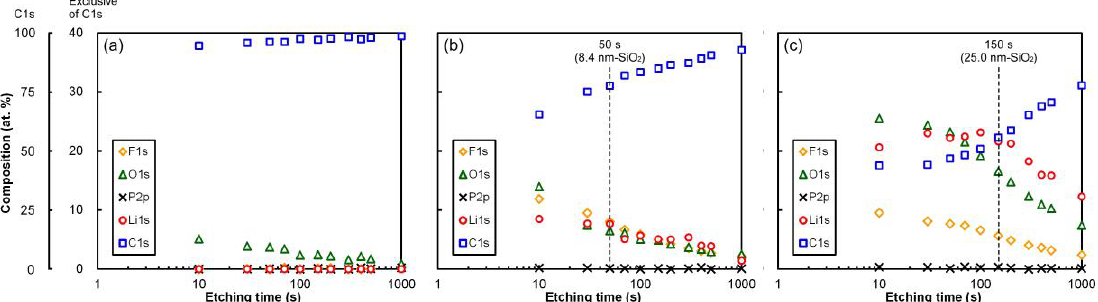
Figure 10. Composition of the pristine and prelithiated HC electrodes as a fuction of the etching time: ( a ) pristine HC; ( b ) shallow prelithiation HC; ( c ) cycling prelithiation HC. The etching time (SiO 2 ) is 0.167 nm s −1 .